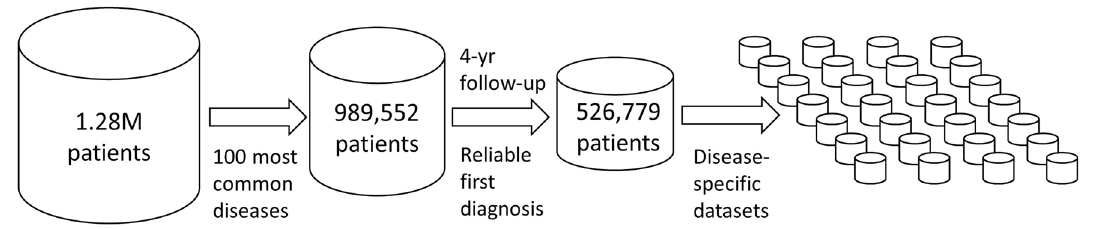
Figure 1. Data preprocessing scheme from original records to 100 index disease datasets.